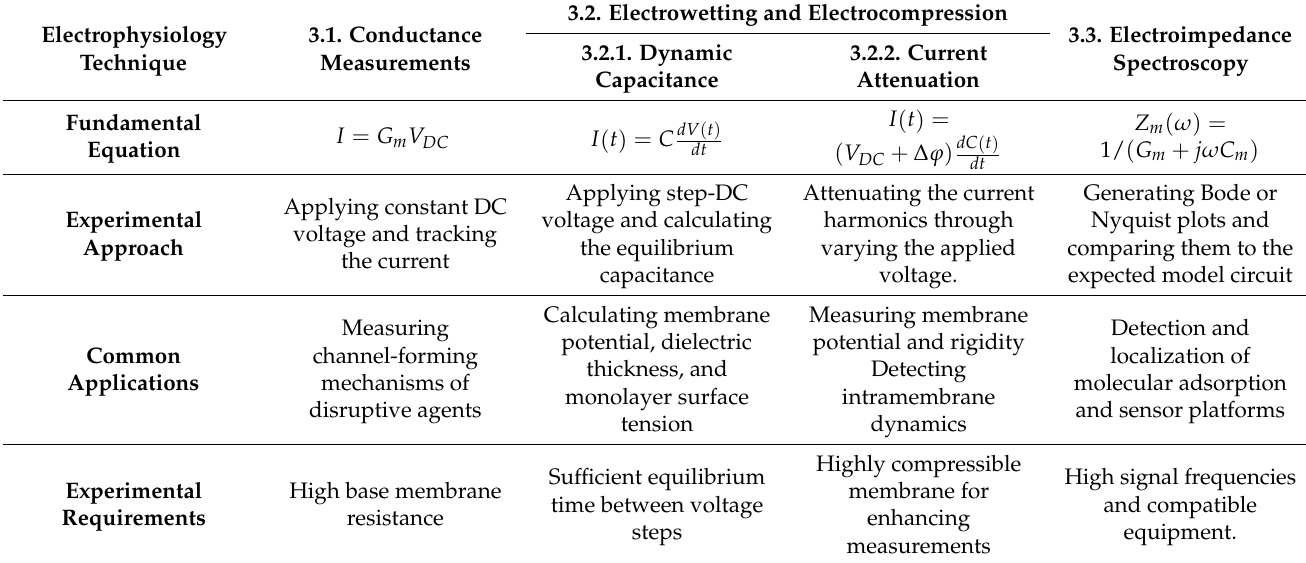
Table 2. Summary of the discussed electrophysiology-based